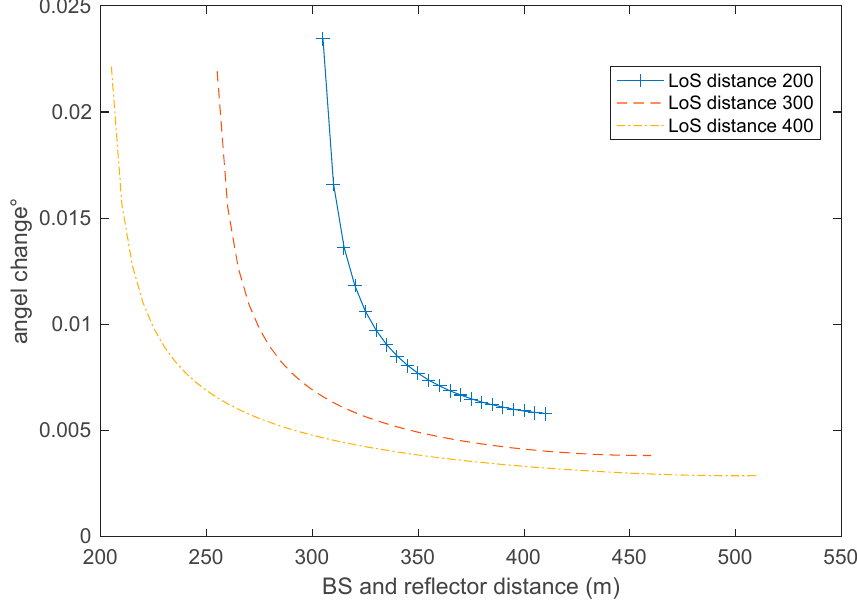
Figure 4. Transmission angle change during one timeslot with a different LoS distance and different distances between the base station (BS) and reflector.